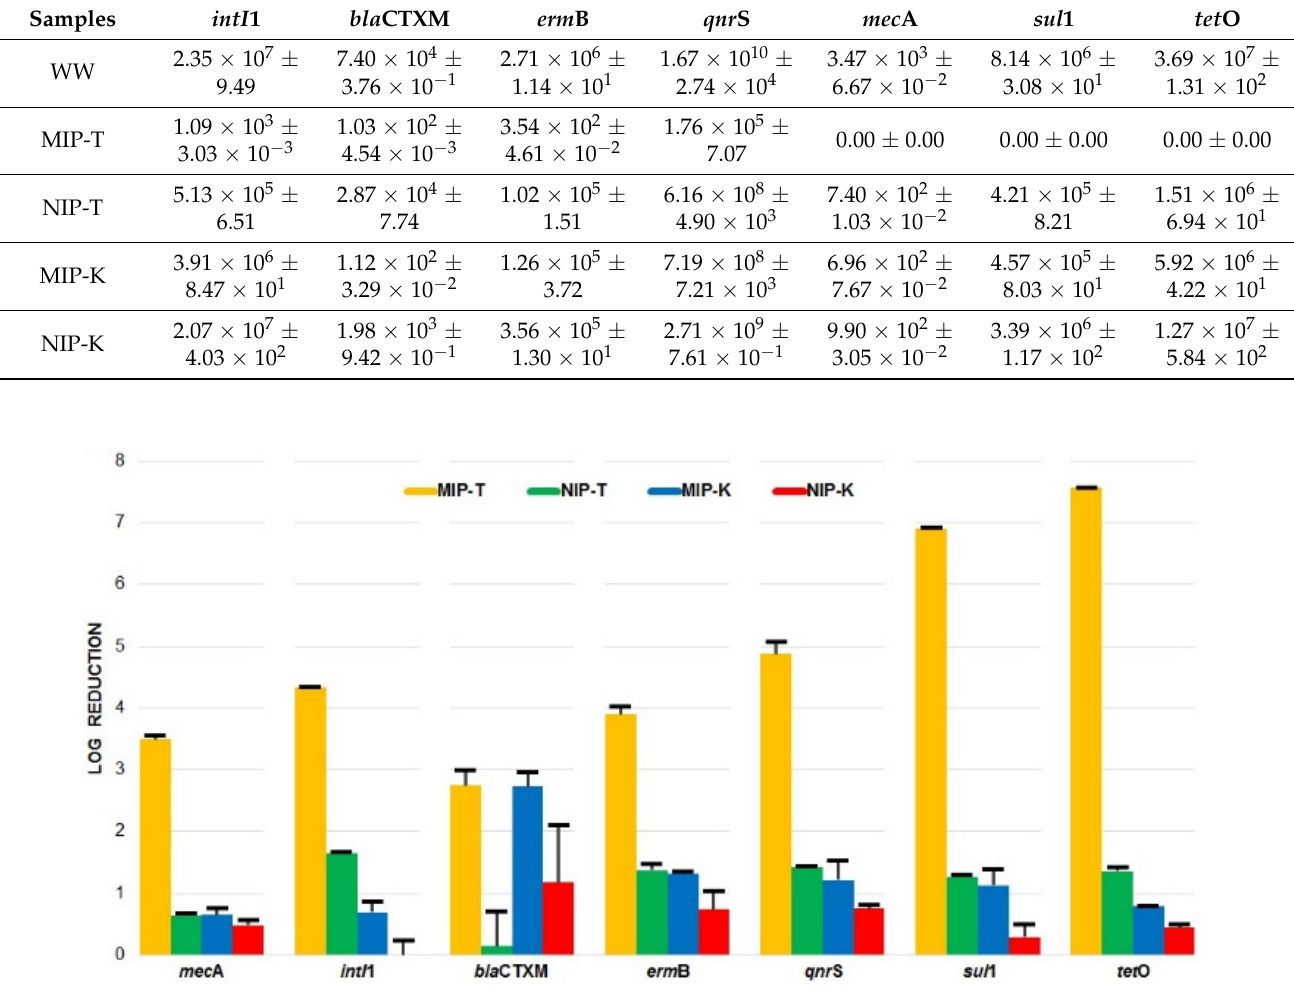
Figure 1. ARG log reductions after treatment of WW with the novel nanomaterials, namely MIP-T (LPS-MIP in tandem with QAS-K), NIP-T (NIP in tandem with QAS-K), MIP-K (MIP with kaolin) and NIP-K (NIP with kaolin).